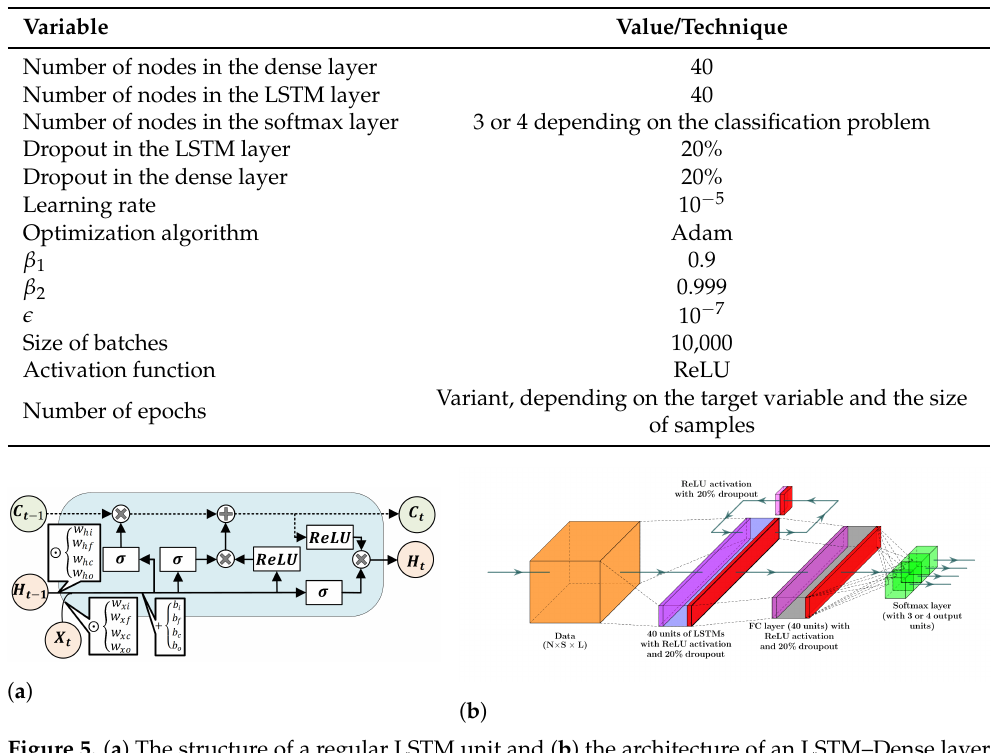
Table 3. The value of adjustable parameters used in the NN classifier model.